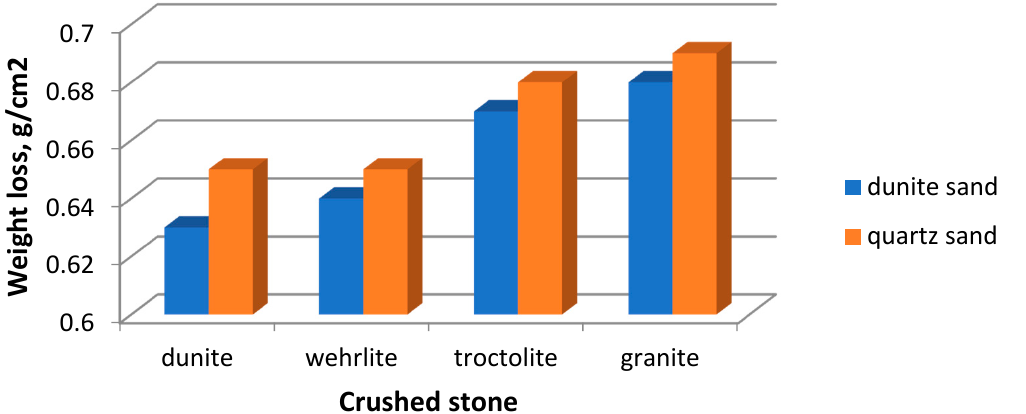
Figure 11. Dependence of the weight loss of concrete samples during abrasion on the aggregate type.